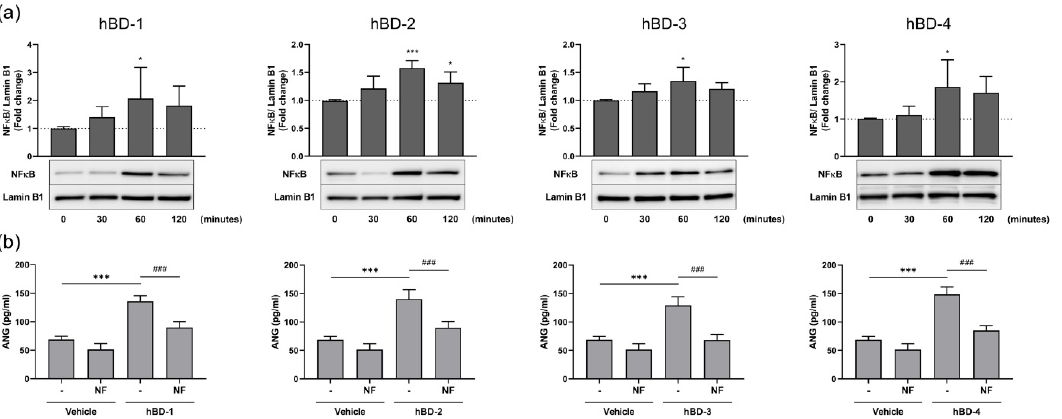
Figure 6. hBDs induce ANG production by activating NF- κ B signaling. ( a ) Human dermal fibro- blasts were stimulated with 20 μ g/mL hBD-1, 20 μ g/mL hBD-2, 10 μ g/mL hBD-3, or 20 μ g/mL hBD- 4 for 5–60 min, and the levels of NF- κ B in nuclear lysates were analyzed by Western blotting. The expression of Lamin B1 is shown as a loading control. * p < 0.05 and *** p < 0.001 compared between the unstimulated (0 min) and the hBD-stimulated groups by one-way ANOVA with Tukey’s multi- ple comparisons test. ( b ) Fibroblasts were preincubated with 40 μ M NF- κ B activation inhibitor II (NF) or solvent (-) for 2 h. Cells were then stimulated for 6 h with 20 μ g/mL hBD-1, 10 μ g/mL hBD- 2, 10 μ g/mL hBD-3, or 20 μ g/mL hBD-4. The concentrations of ANG in cell-free supernatants were determined by ELISA. *** p < 0.001 compared between the presence and absence of hBDs without inhibitor; ### p < 0.001 compared between the inhibitor-treated and untreated groups with hBD stimulation by one-way ANOVA with Tukey’s multiple comparisons test. All results are the means ± SDs of 4–6 independent experiments.